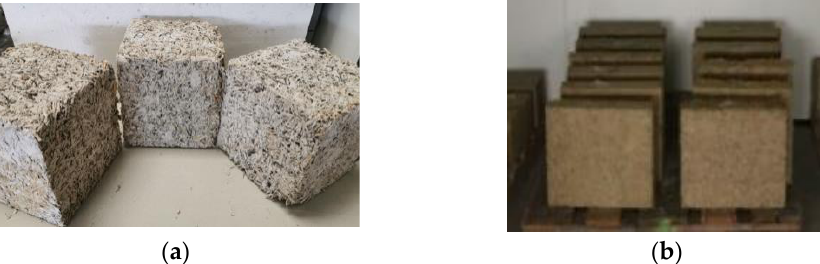
Figure 5. Rapeseed concrete samples for ( a ) mechanical test; ( b ) thermal conductivity